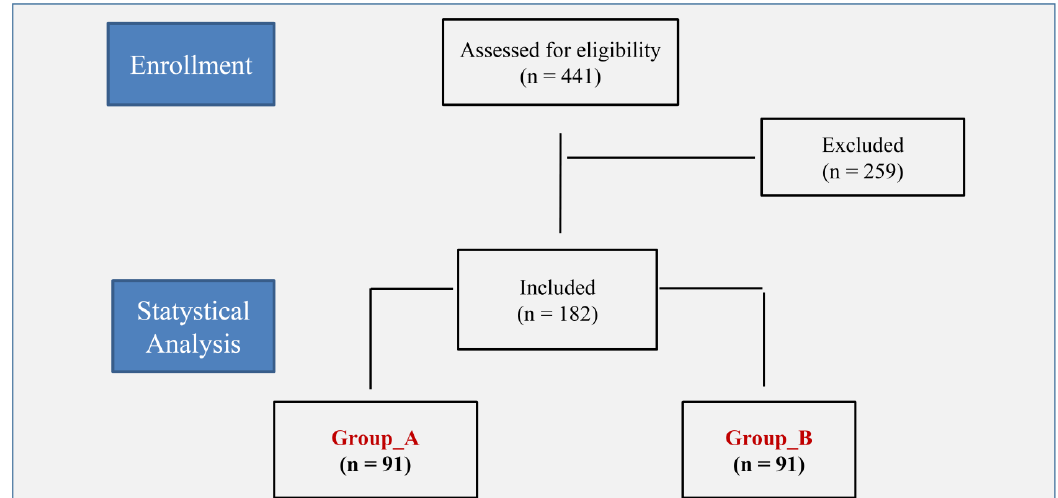
Figure 1. Flow diagram of the study. Table 1. General features of the study population (categoric and continuous variables expressed as number/percentage, or mean ± standard deviation, respectively).